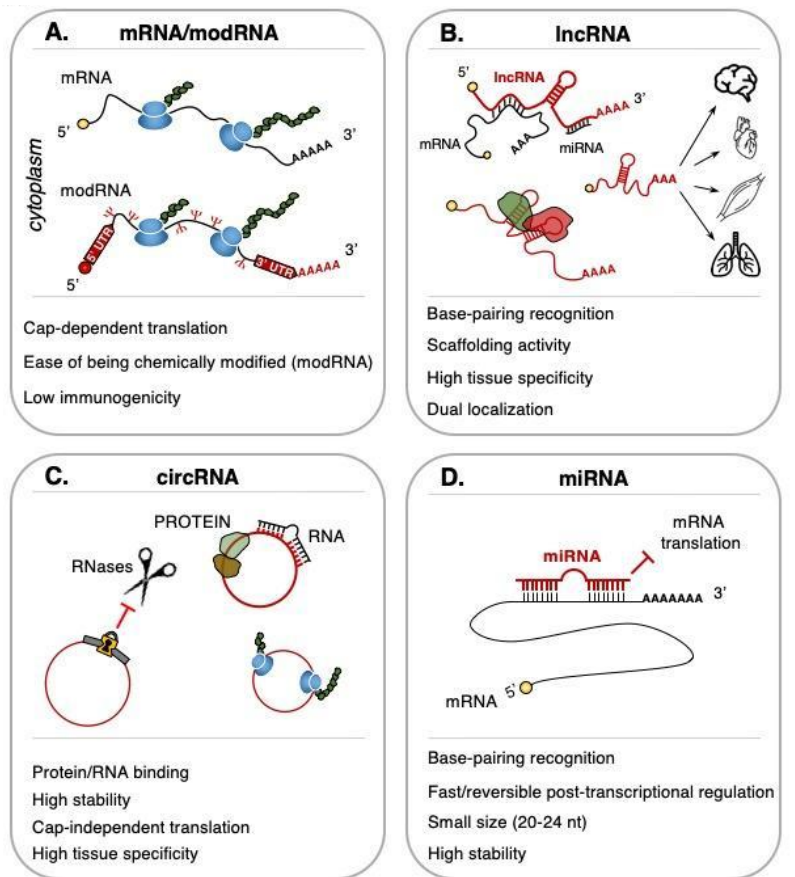
Figure 1. Chemical and structural properties of RNA that are usable for therapeutics. Different RNA types are shown as follow: ( A ) mRNA/modRNA. The uridine into pseudouridine substitution in modRNAs is represented by the greek Ψ symbol (red); ( B ) lncRNA; ( C ) circRNA. Locket (yellow) represents the covalently closed structure which makes circRNA resistant to exonucleases (RNases); ( D ) miRNA. See text for further details.